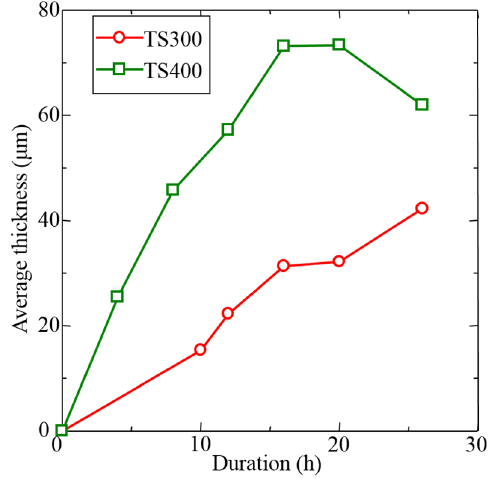
Figure 5. Weight increase of 50 steel balls versus duration of mechanical coating at different revolution speeds. Coatings 2017 , 7 , 53